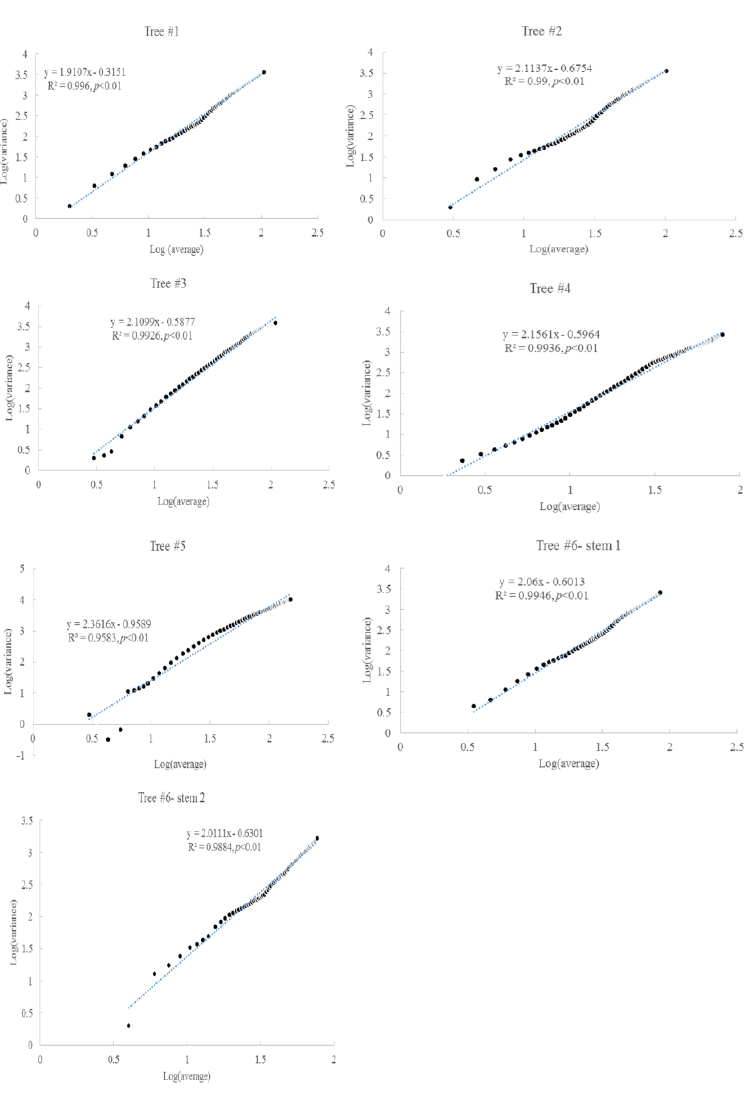
Figure 4. Taylor’s power law in the radial growth for six Chinese Torreya trees.